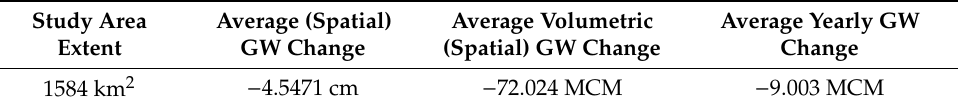
Table 4. Groundwater variations from